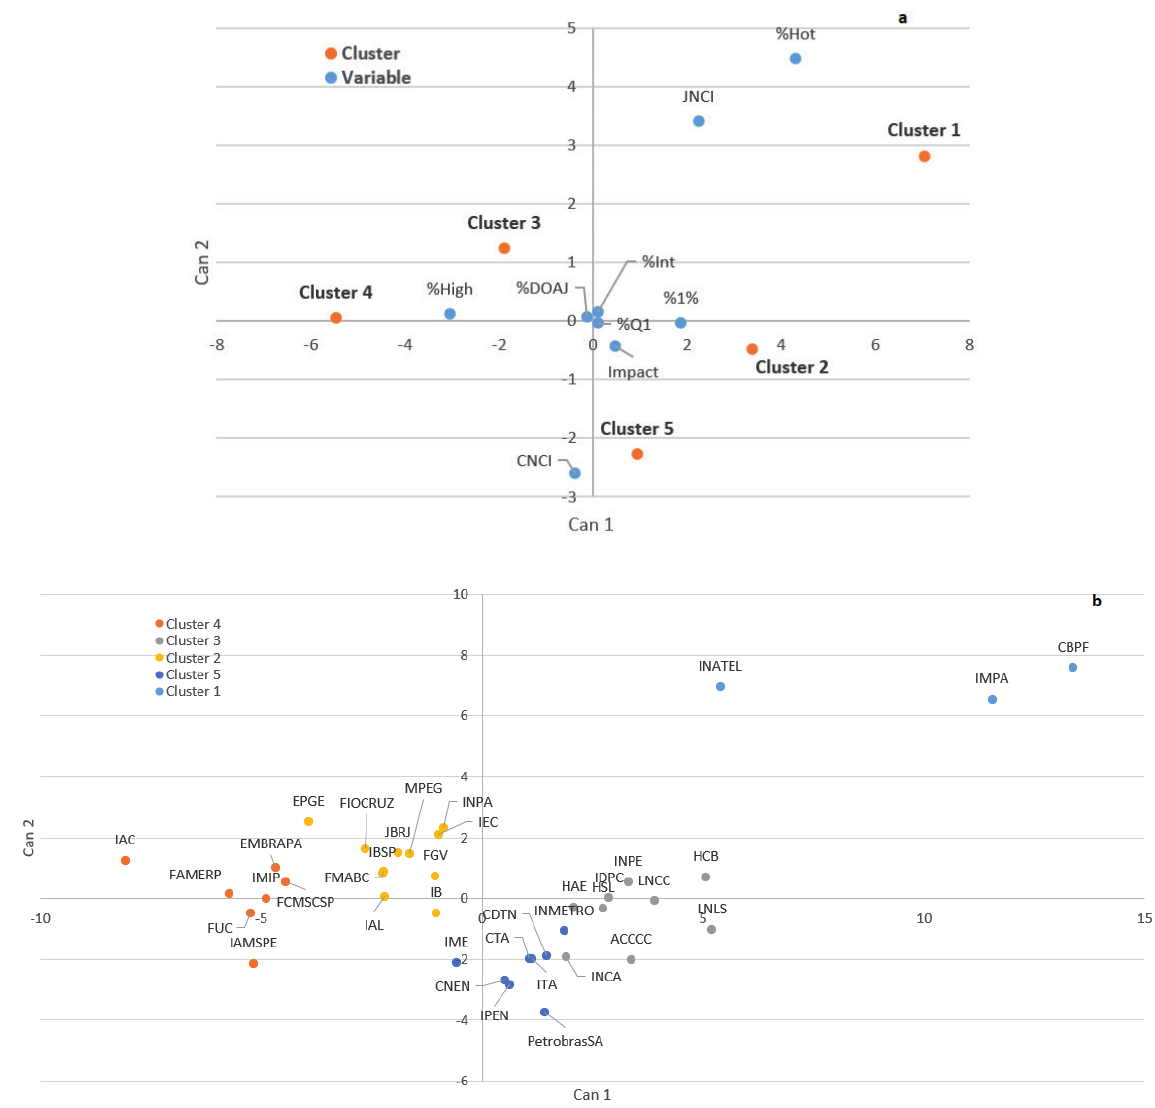
Figure 5. Canonical analysis for means cluster and variables (a) and separation by cluster (b) for research institutions in Brazil (Cluster 1 has highest impact factor and Cluster 5